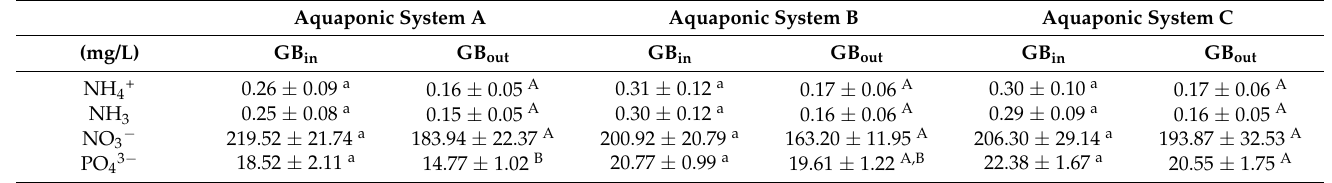
Table 3. Water quality of the three aquaponic systems over the 45-day period.